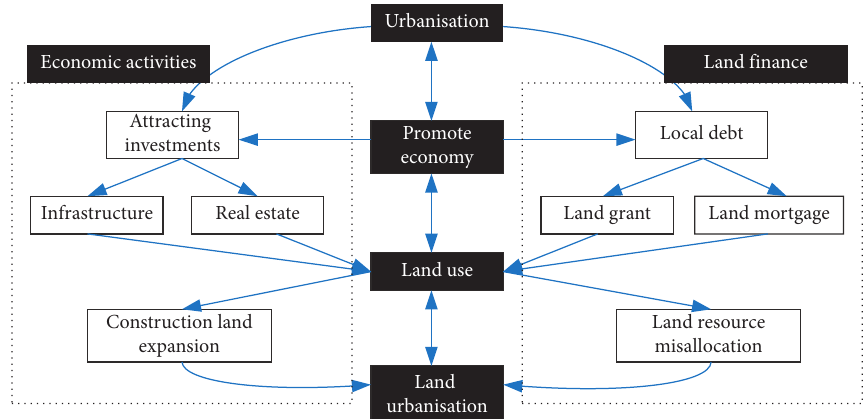
Figure 1: Logical relationship between local debt and land